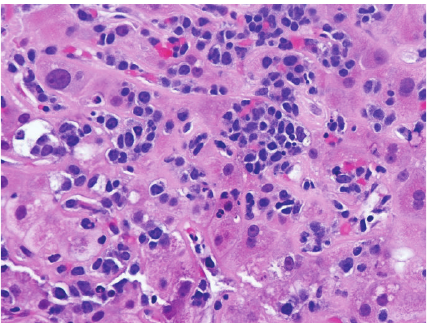
Figure 1: High power image of liver demonstrating sinusoids packed with atypical plasma